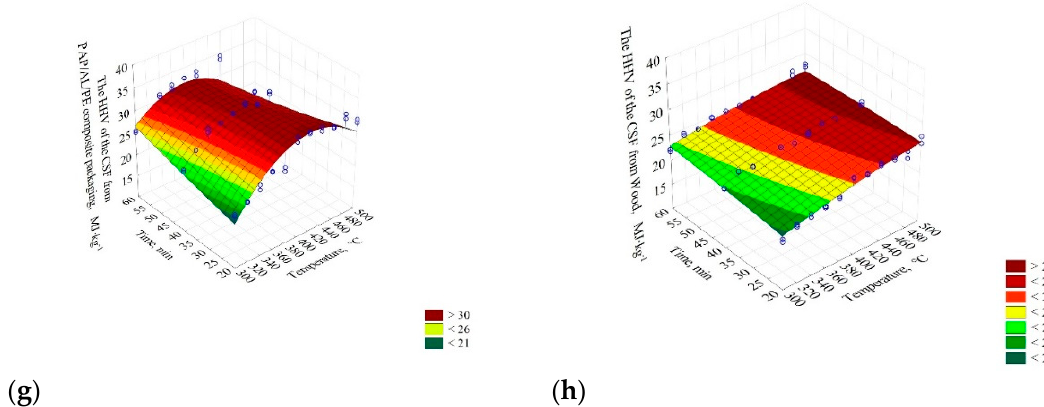
Figure 3. The influence of low-temperature pyrolysis temperature and residence time on the high heating value of CSF from ( a ) carton; HHV(T,t) = 6.99959 + 0.0376341 · T − 4.51616 · 10 − 5 · T 2 + 0.0958599 · t − 0.00121729 · t 2 , ( b ) fabric; HHV(T,t) = 5.27185 + 0.0254657 · T + 2.32626 · 10 − 5 · T 2 + 0.256539 · t − 0.00309588 · t 2 , ( c ) kitchen waste; HHV(T,t) = 1.95489 + 0.0758155 · T + 0.127447 · t − 6.77225 · 10 − 5 · T 2 + 0.00050108 · t 2 − 0.000392949 · T · t, ( d ) paper; HHV(T,t) = 26.6224 − 0.0489416 · T + 5.21567 · 10 − 5 · T 2 − 0.0871204 · t + 0.000907272 · t 2 , ( e ) plastic; HHV(T,t) = − 26.9986 + 0.383563 · T − 0.358936 · t − 0.000485497 · T 2 + 0.00735668 · t 2 − 0.000682253 · T · t, ( f ) rubber; HHV(T,t) = 28.781 + 0.100862 · T − 0.0882796 · t − 0.000193804 · T 2 + 0.00338057 · t 2 − 0.000857182 · T · t, ( g ) PAP/AL/PE composite packaging pack; HHV(T,t) = − 124.359 + 0.711538 · T + 0.648268 · t − 0.00079769 · T 2 + 0.000440254 · t 2 − 0.00174132 · T · t, ( h ) wood; HHV(T,t) = 1.36811 + 0.0757645 · T + 0.157354 · y − 5.58308 · 10 − 5 · T 2 − 0.000491547 · t 2 − 0.000220373 · T · t . The chosen best-fitting mathematical models of the influence of the pyrolysis temperature and resi- dence time on the HHV of CSF produced from different RDF components are